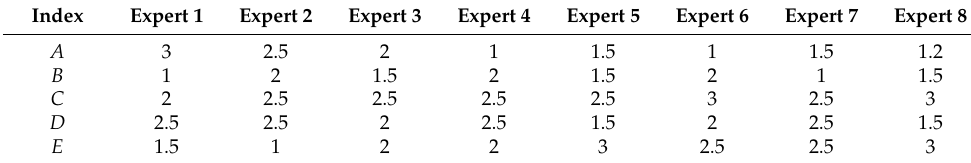
Table 4. Index importance